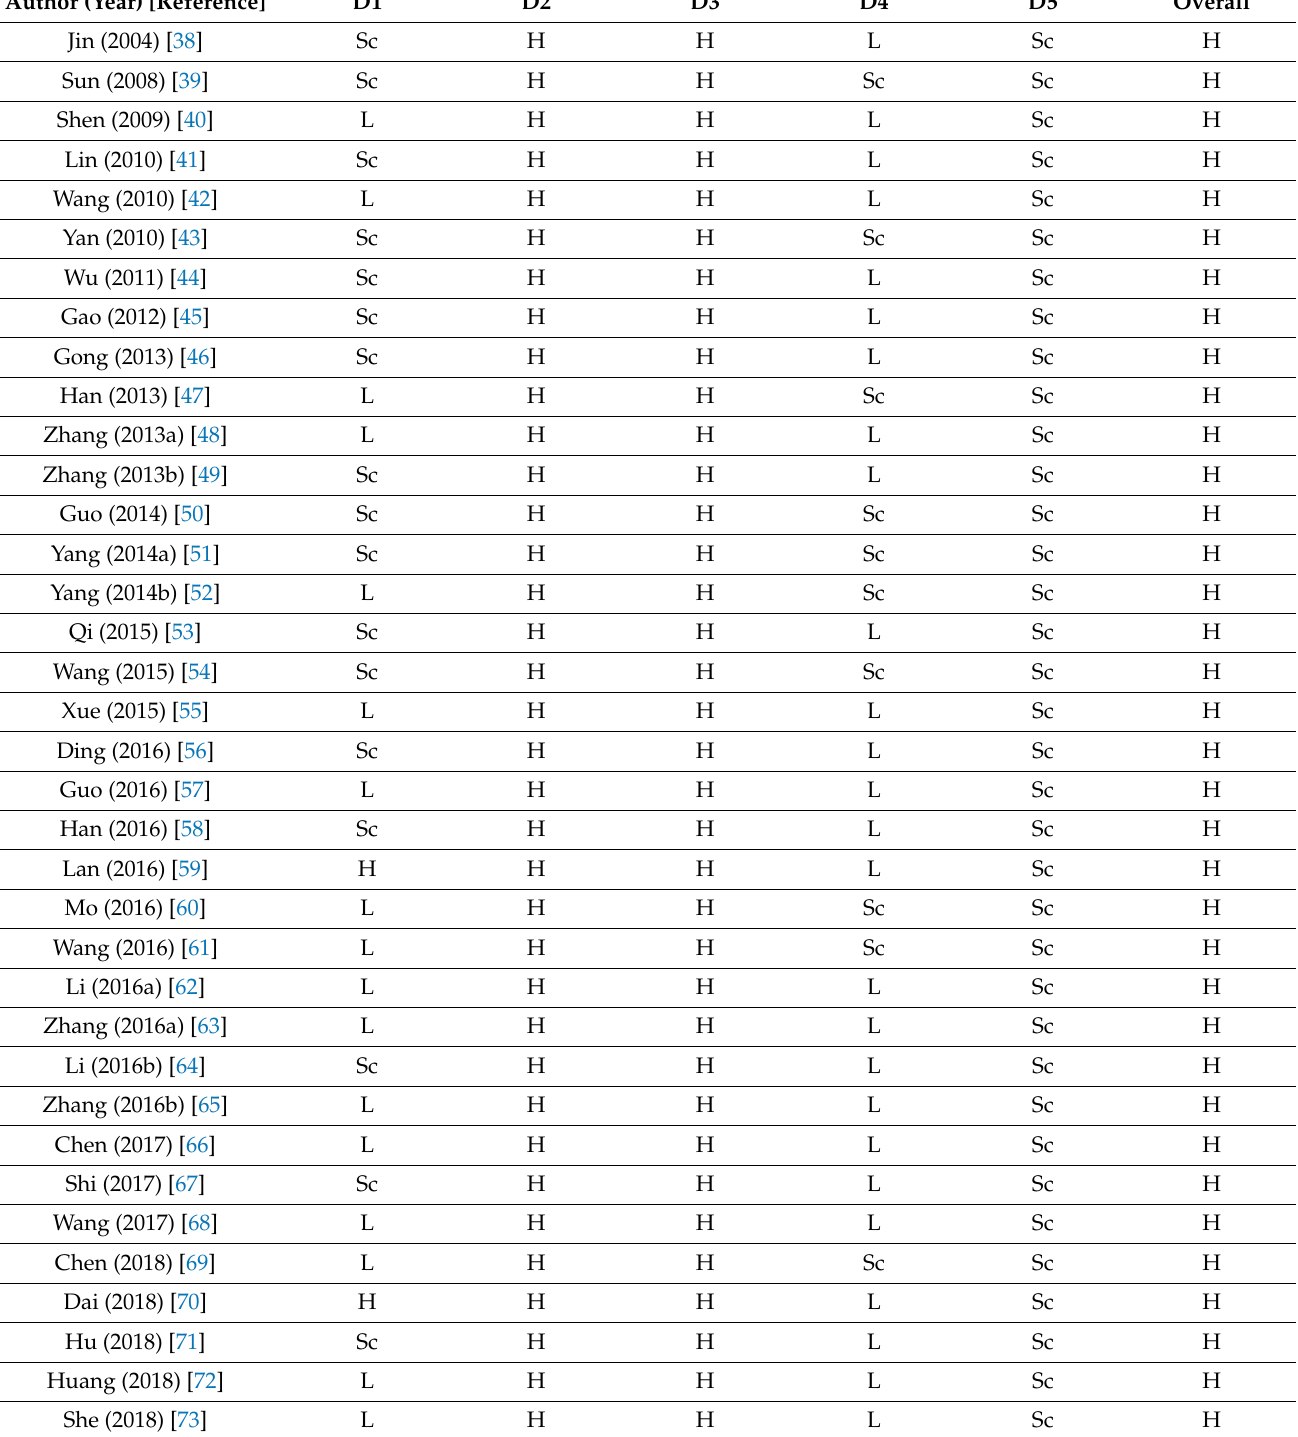
Table 2. Methodological quality of the included studies according to the risk of bias